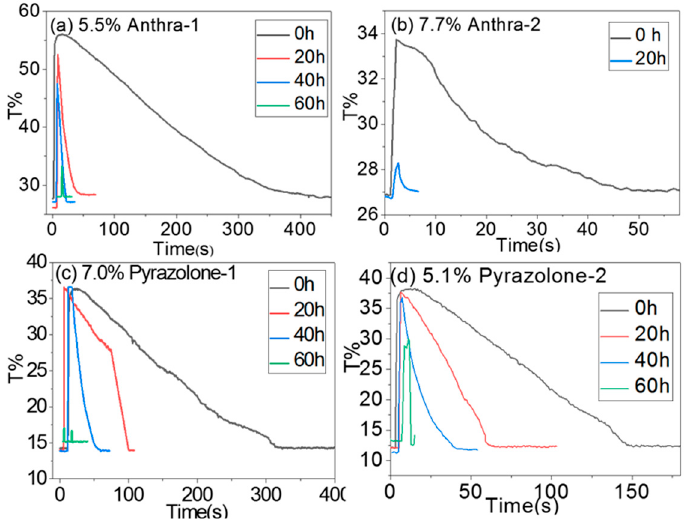
Figure 7. Backflow properties of EFD devices with dyes under different irradiation times. (Irradiation condition: 0.55 W/m 2 (340 nm); Temperature 45 °C). ( a ) 5.5% Anthra-1, ( b ) 7.7% Anthra-2, ( c ) 7.0% Pyrazolone-1, ( d ) 5.1% Pyrazolone-2.